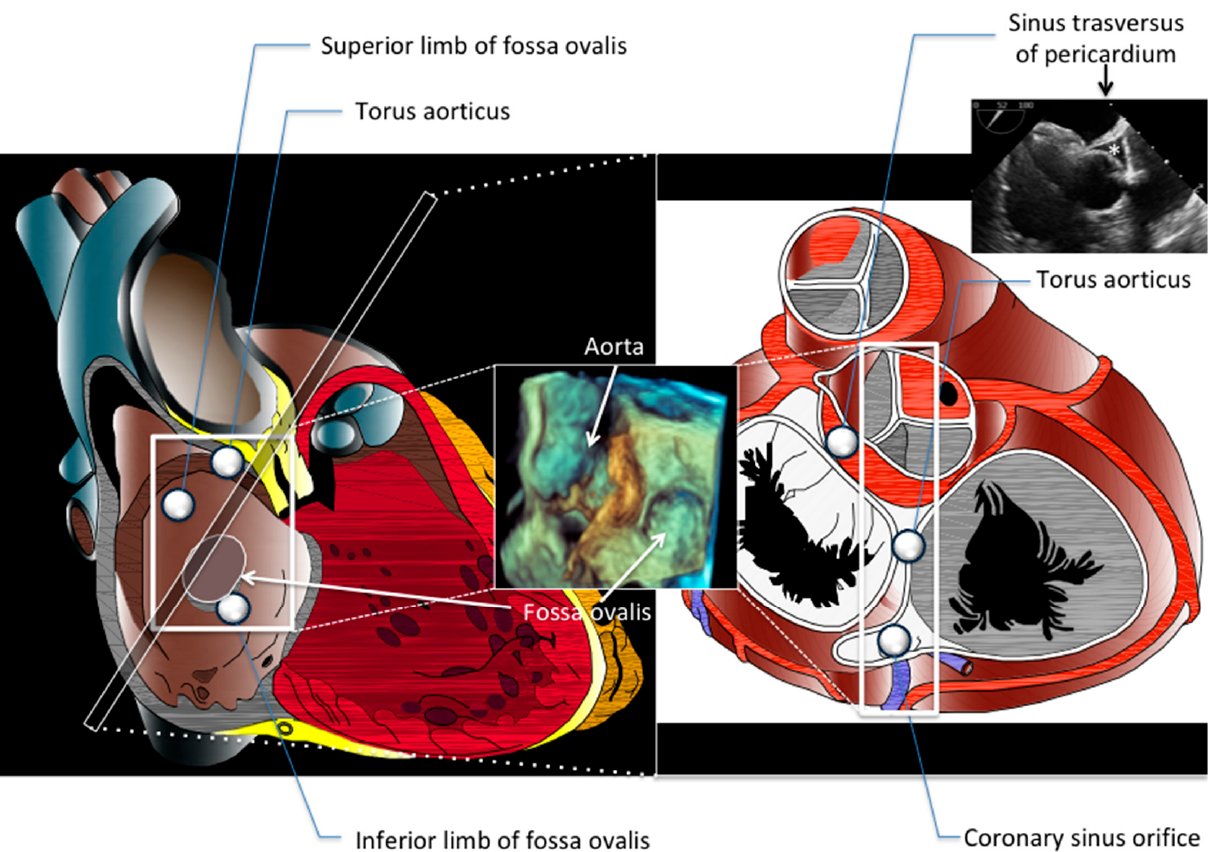
Figure 1. Anatomy of atrial septum. Left panel shows right atrial view of atrial septum and anatomic relationship with superior vena cava, inferior vena cava, coronary sinus. The bulging of aorta toward the atrial septum (torus aorticus) is shown. The central insert is a TEE three-dimensional view showing the relationship between aortic root and fossa ovalis. The right panel represents a cross-anatomical section set at the level shown in the left panel. The extracardiac space between the aortic root (anteriorly) and atrial chambers (posteriorly) is the sinus transversus of pericardium. A TEE view of such space is presented in the right-top insert (*).